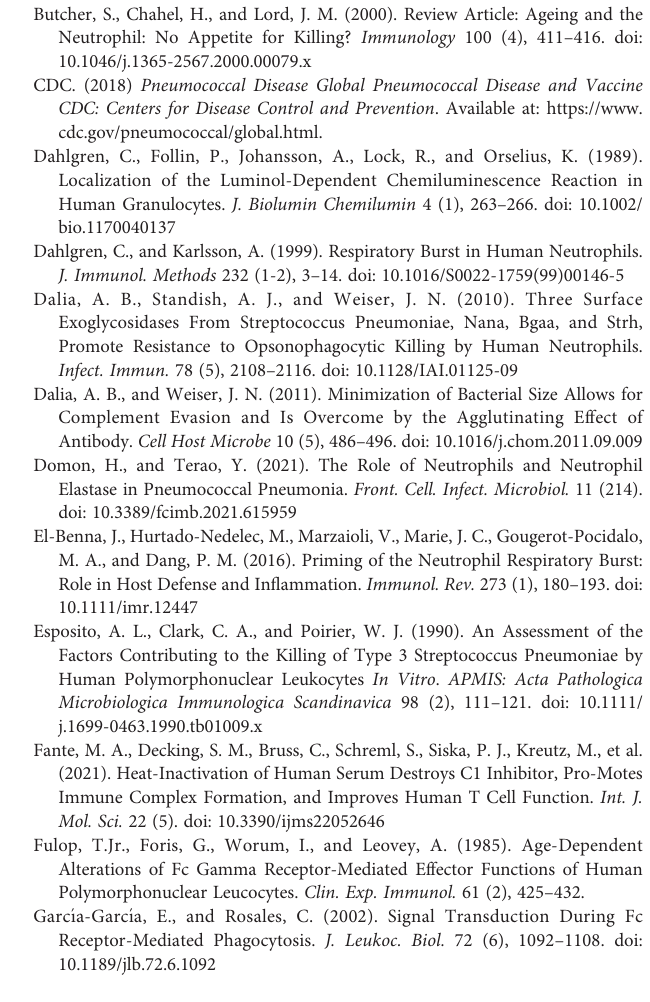
One-way ANOVA followed by Dunnett ’ s multiple comparisons test. * denotes p<0.05, ** denotes p<0.01, and *** denotes p<0.001. Supplementary Figure 3 | Aging does not affect production of ROS, MPO, release of extracellular DNA or bacterial uptake by PMNs in response to antibody- opsonized S. pneumoniae. PMNs were isolated from the bone marrow of naïve youngand oldmale C57BL/6 mice andinfected with S. pneumoniae pre-opsonized with heat inactivated immune sera from young mice (+ S.p ) or mock infected with heat inactivated immune sera alone (uninfected) as indicated. (A, B) Forty minutes post-infection, MPO concentrations present in the pellets or released in the supernatants were measured using ELISA. Data are pooled from three separate experiments. (C) The levels of extracellular DNA released in the supernatants were also measured by SYTOX Green. Data are pooled from three separate experiments (n=3 biological replicates per group). (D, E) Production of intracellular and extracellular ROS over time following infection was measured by chemiluminescence of luminol and isoluminol plus HRP respectively. Data are representative of one of three separate experiments where each condition was testedin triplicate (n=3 technical replicates) per experiment. (F) PMNswere infected for 15 minutes with GFP tagged S. pneumoniae pre-opsonized with heat- inactivated immune sera. The amount (MFI) of intracellular bacteria was determined be fl ow cytometry using inside-out staining. Data are pooled from three separate experiments (n=3 biological replicates per